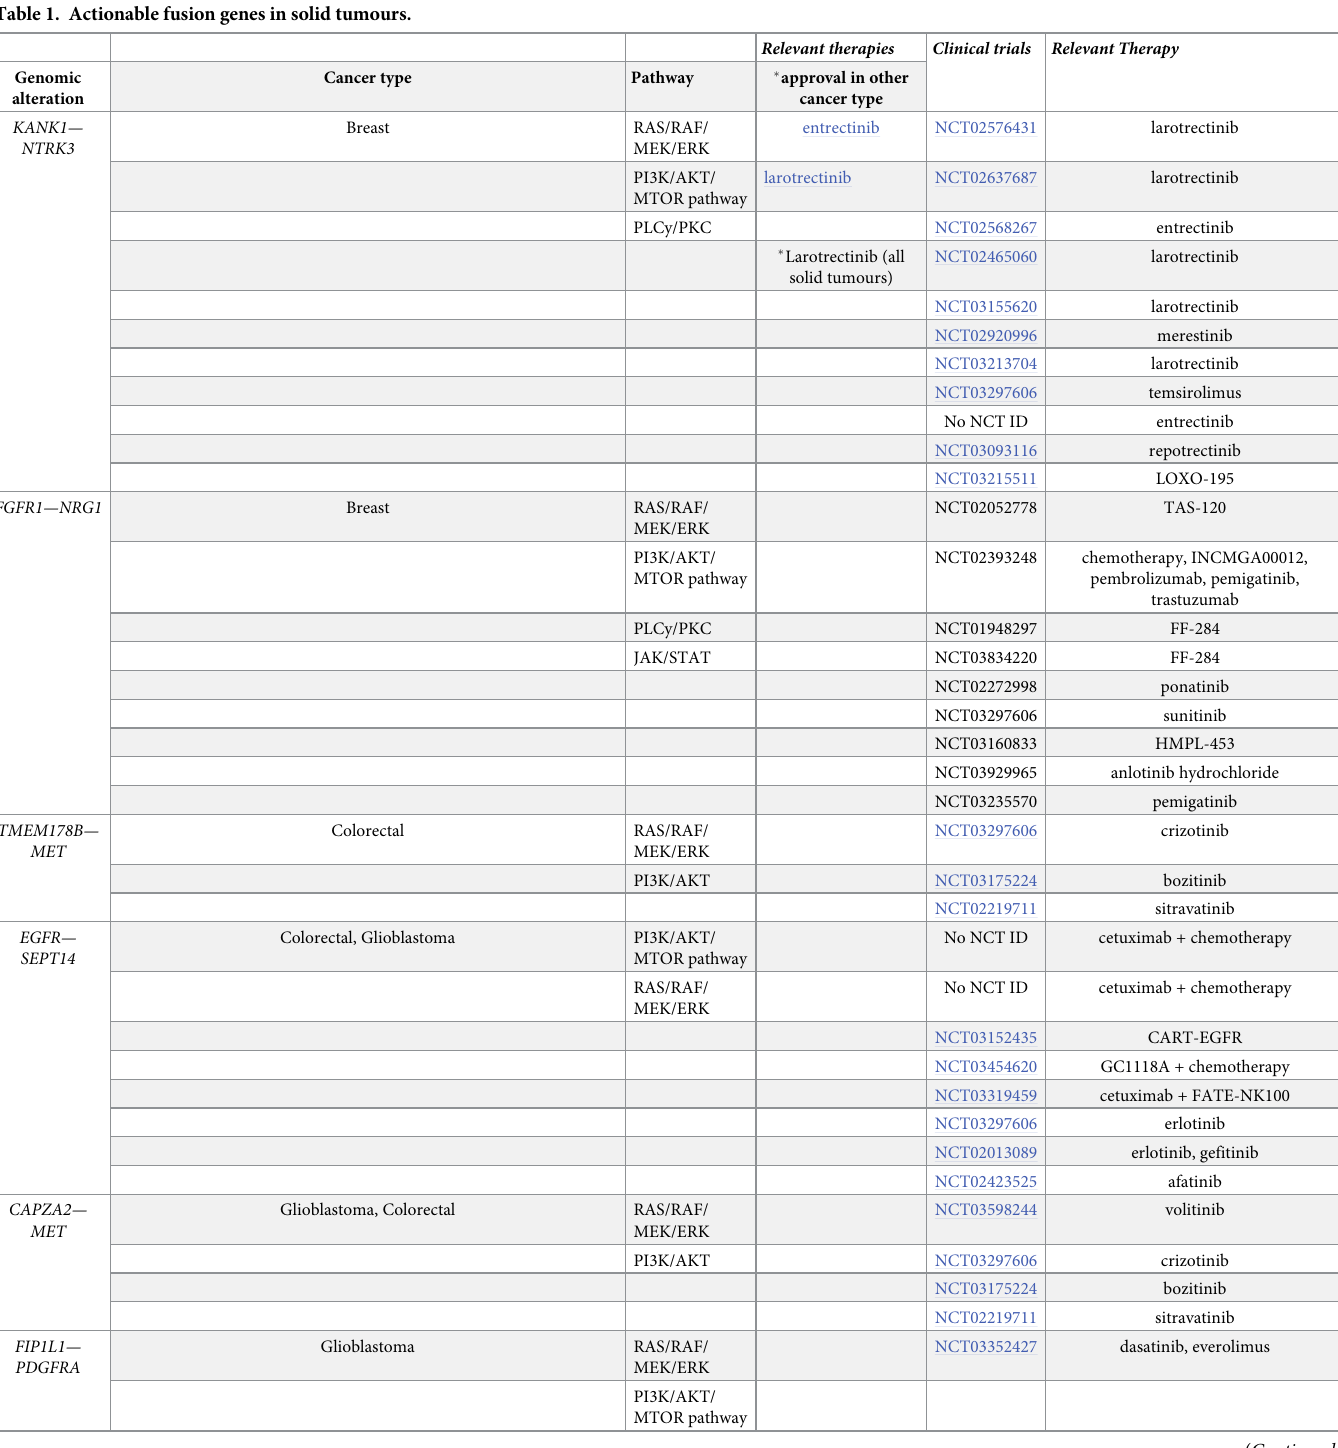
Table 1. Actionable fusion genes in solid